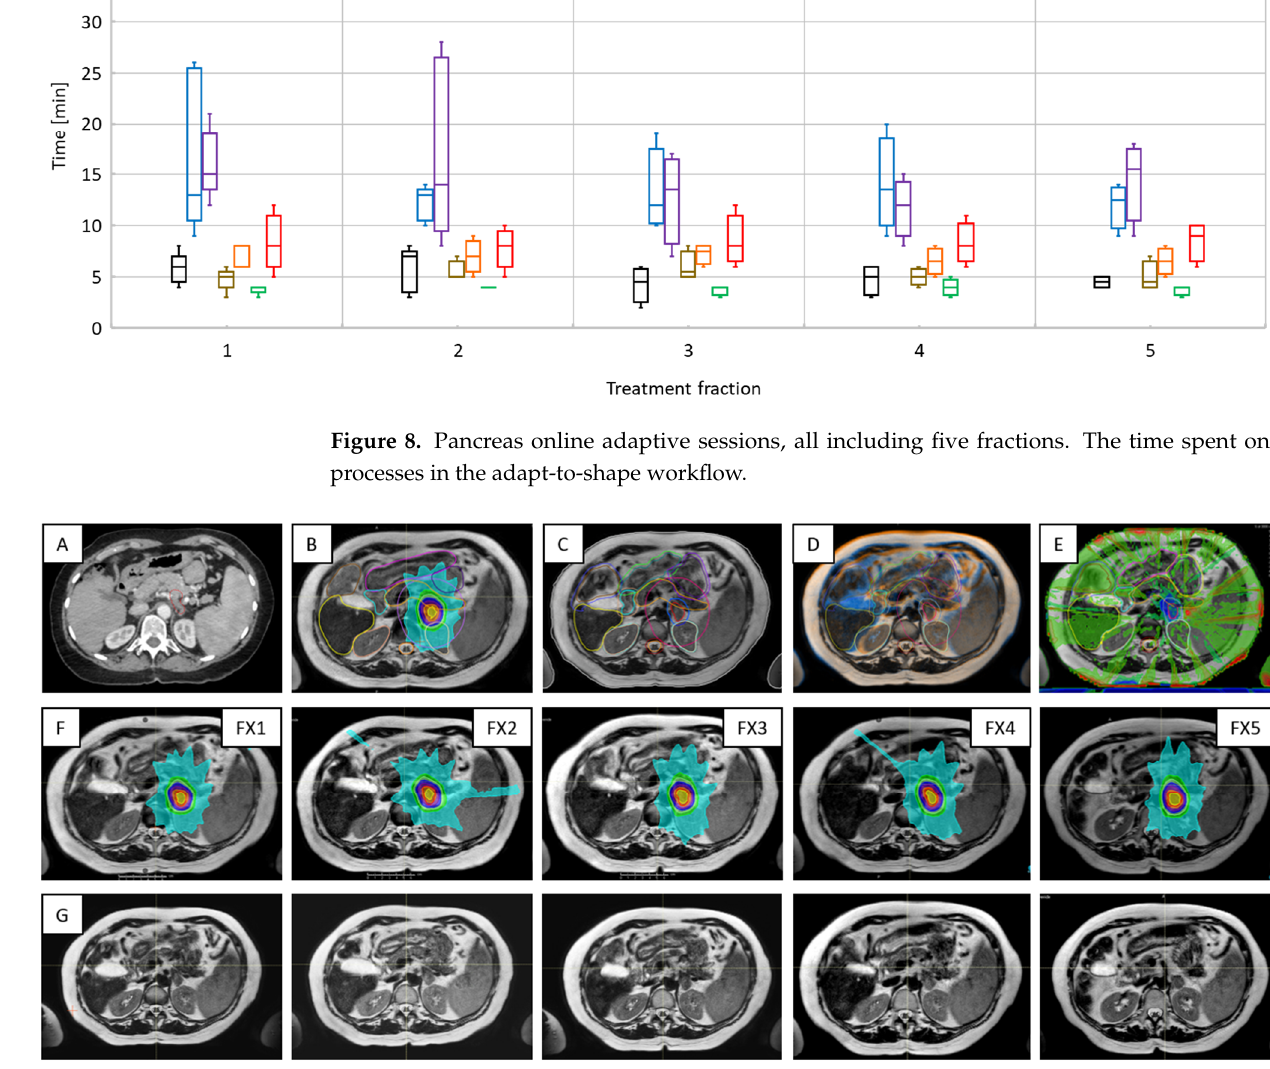
Figure 9. Highlights of the online adaptive workflow for a pancreas case —i.e., Patient 10 in